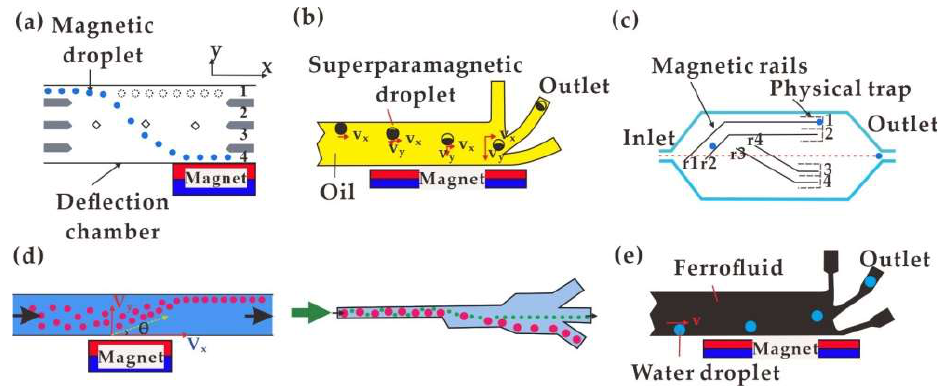
Figure 4. Different magnetic sorting methods: ( a ) Based on the difference in magnetism [136]; ( b ) Droplets deflected to the indicated outlet [18]; ( c ) Magnetic rails [21]; ( d ) Based on the difference in flow speed and droplet size [19]; ( e ) Deflect of water droplets in ferrofluid medium [137].